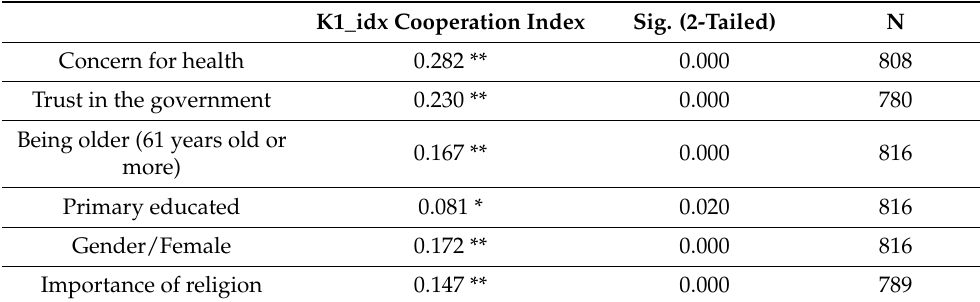
Table 3. Correlation between cooperation possible intervening